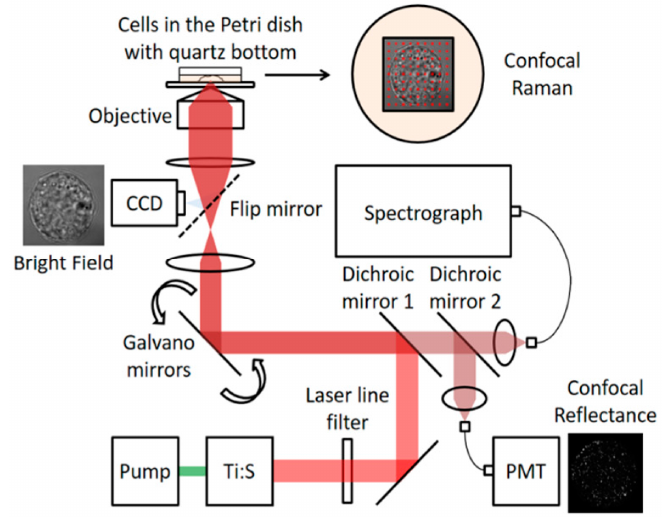
Figure 4. Depicts a general layout for confocal Raman